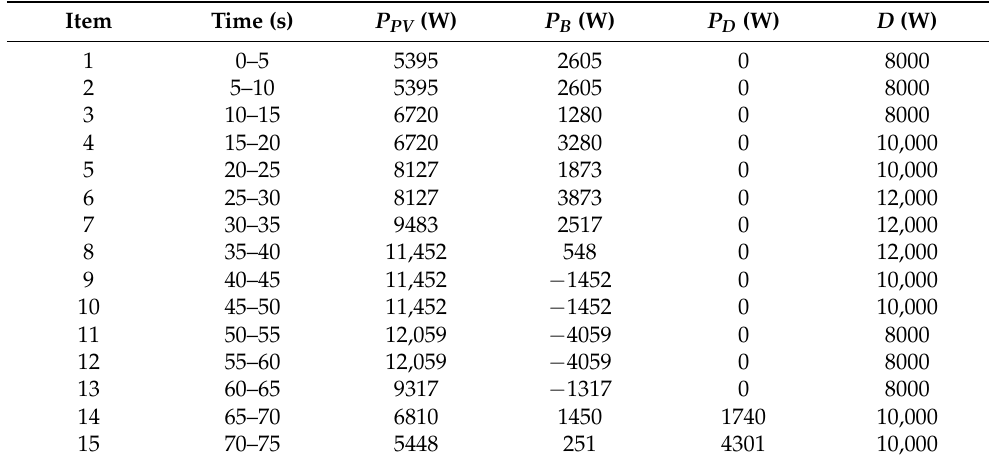
Table 5. Active Power microgrid with